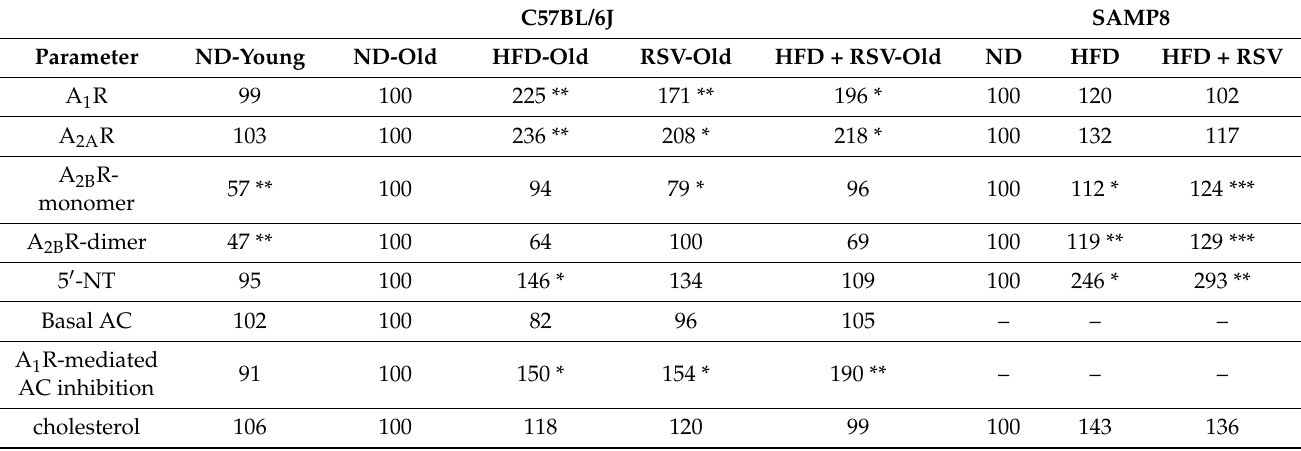
Table 1. Summary of changes detected in the cerebral cortex of C57BL/6J and SAMP8